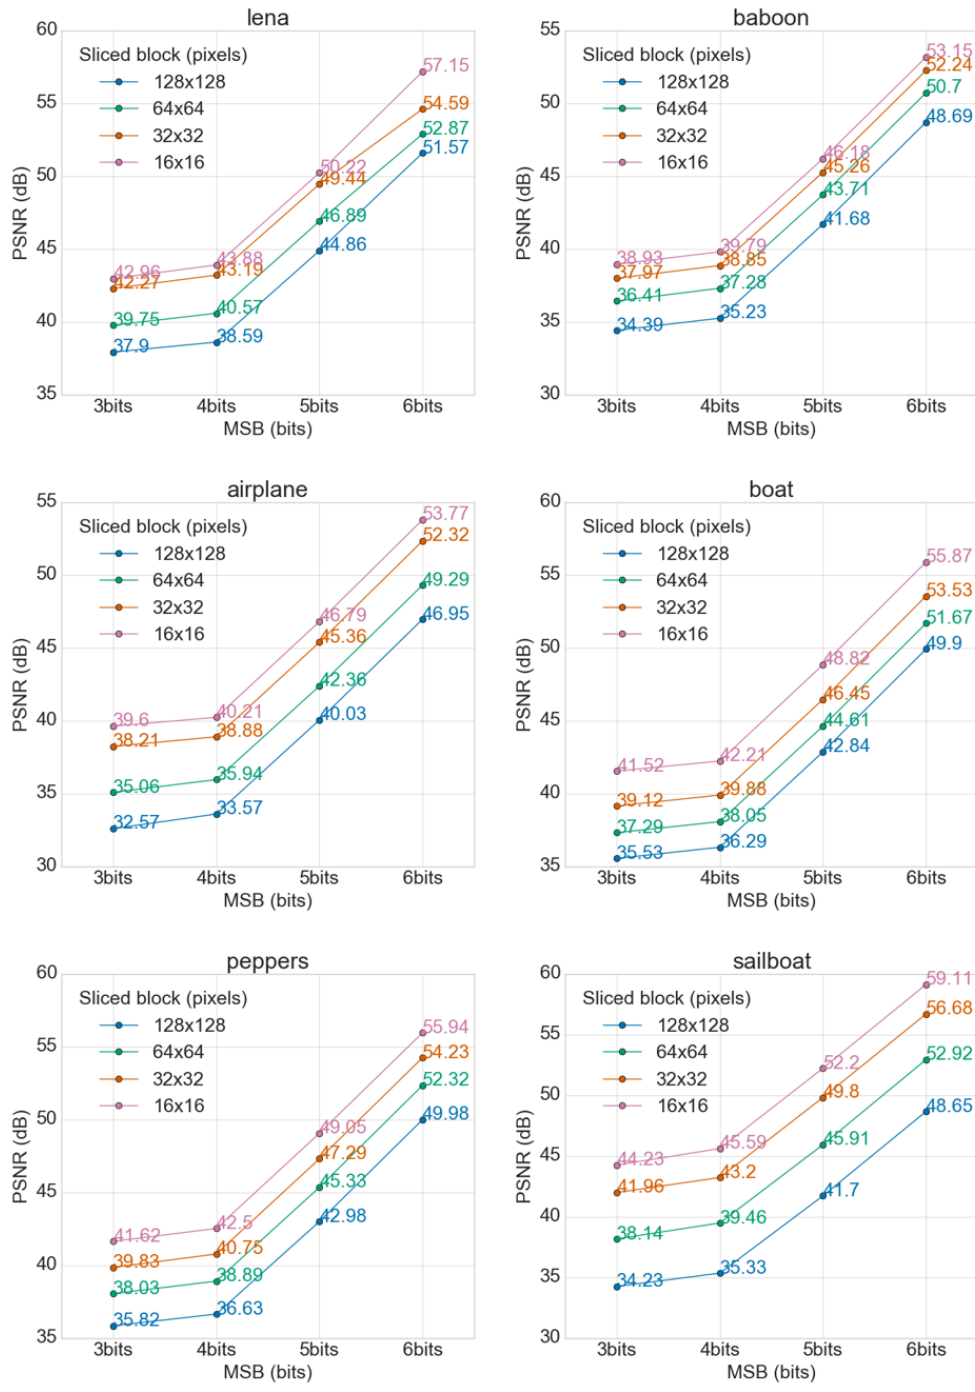
Figure 21. PSNR value